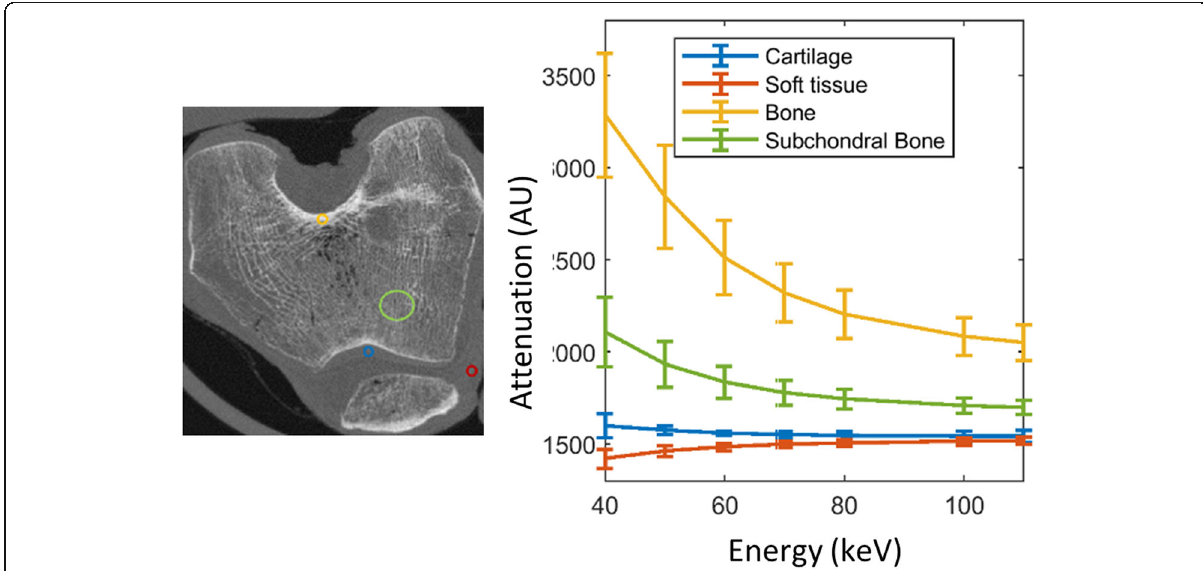
Fig. 3 Right: Energy fingerprints of the different joint tissues computed from the virtual monoenergetic images. Attenuation versus energy for the regions of interest shown in the left panel: patella cartilage (blue), soft tissue different from cartilage (red), cortical bone (yellow), and subchondral bone (green). Plot shows mean and standard deviation across subjects for the selected regions of